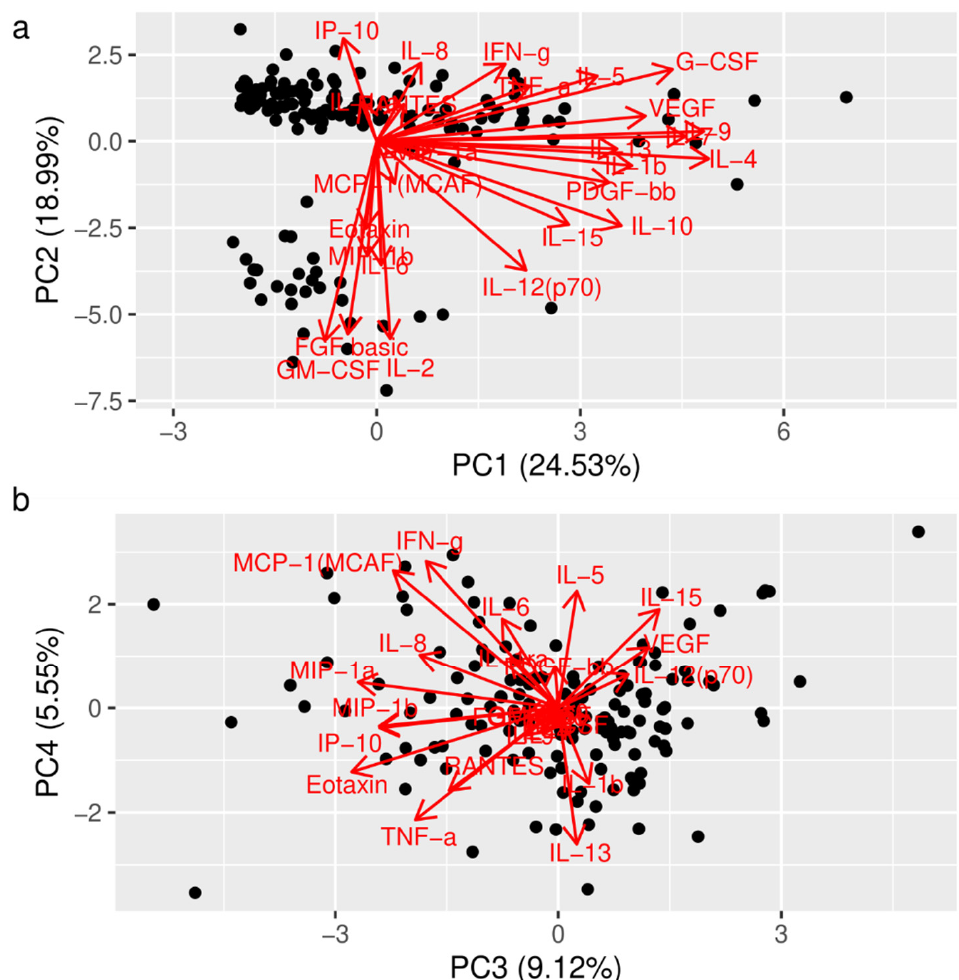
Figure 1. The association of specific cytokines with the first four PCs. Figure Legend: The biplot shows the orientation of the different cytokines with respect to the first and the second component ( a ), and the third and the fourth component ( b ), respectively. The biplots showing the orientation of the cytokines concerning the first four PCs. Abbreviations: PC (principal component); IL (interleukin); TNF (tumor necrosis factor); IFN (interferon); MIP (macrophage inflammatory protein); MCP (monocyte chemoattractant protein); G-CSF (granulocyte colony-stimulating factor); IL-1ra (interleukin-1 receptor antagonist); FGF (fibroblast growing factor); IP-10 (interferon γ induced pro- tein 10); PDGF (platelet-derived growth factor); RANTES (regulated upon activation, normal T cell expressed and secreted); VEGF (vascular endothelial growth factor).